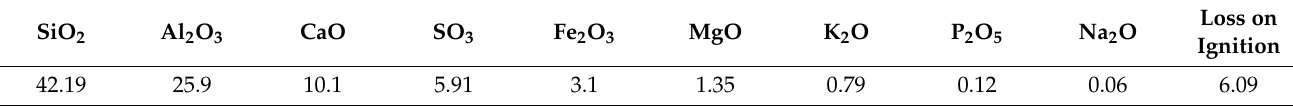
Table 2. Main chemical compositions of CFB-BA (%).